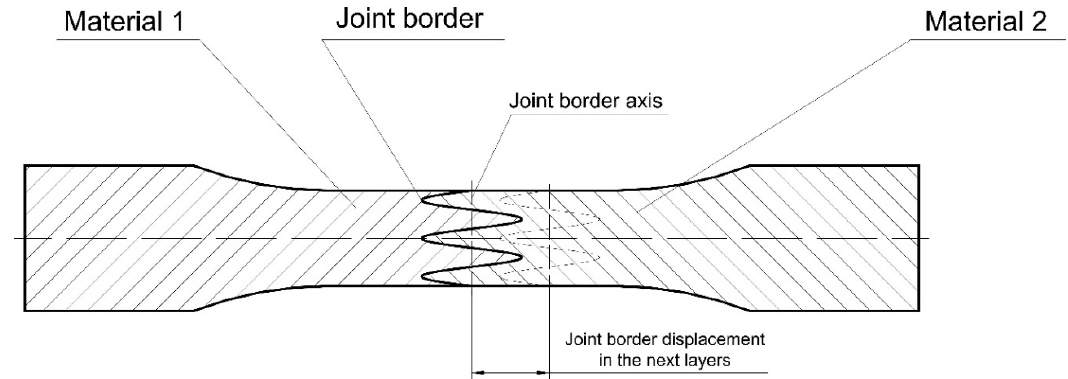
Figure 4. The joint manufacturing procedure for each layer.